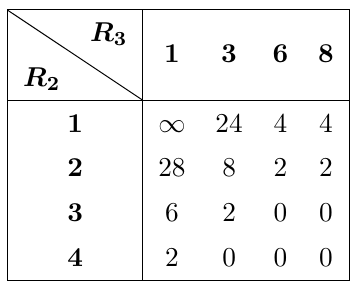
Maximal value of the hyper- charge, which allows for perturbative gauge couplings below 10 15 GeV ( N F = 2 and the VL mass is set at 10